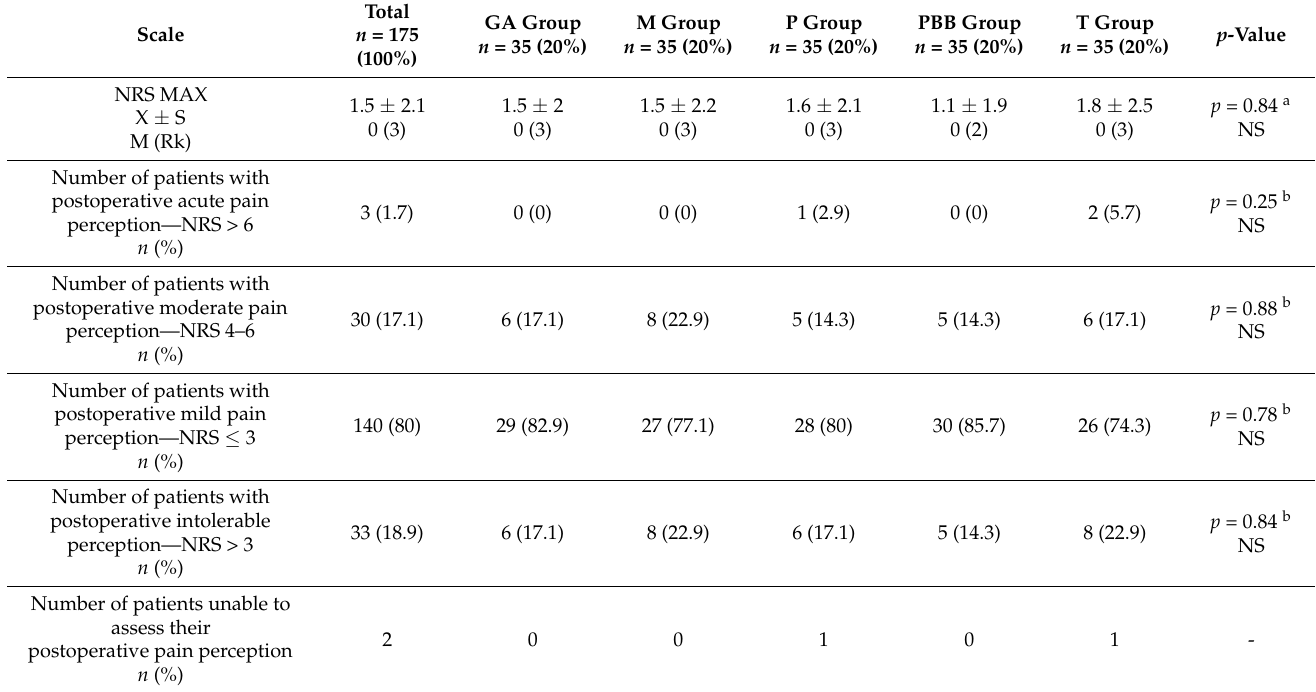
Table 2. Rates of postoperative pain perception in patients regarding group